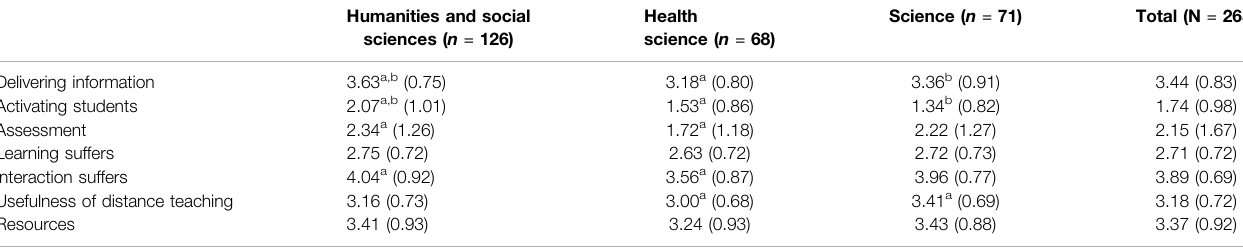
TABLE 2 | Means and standard deviations of major variables as a function of academic fi eld.